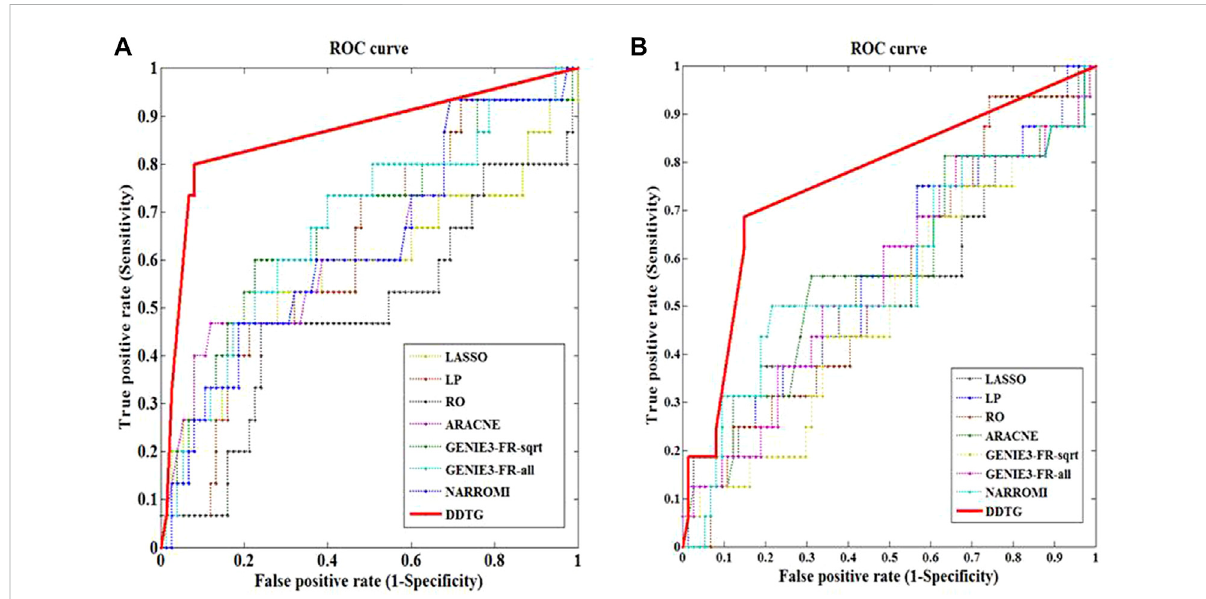
FIGURE 4 ROC curves ofseveralmethods onnetworkswith differentsizes. The solidline with star points istheROC curveofmethodDDTG. (A) The ROC curves on network_1 from DREAM4 datasets with size 10. (B) The ROC curves on network_2 from DREAM4 datasets with size 10.